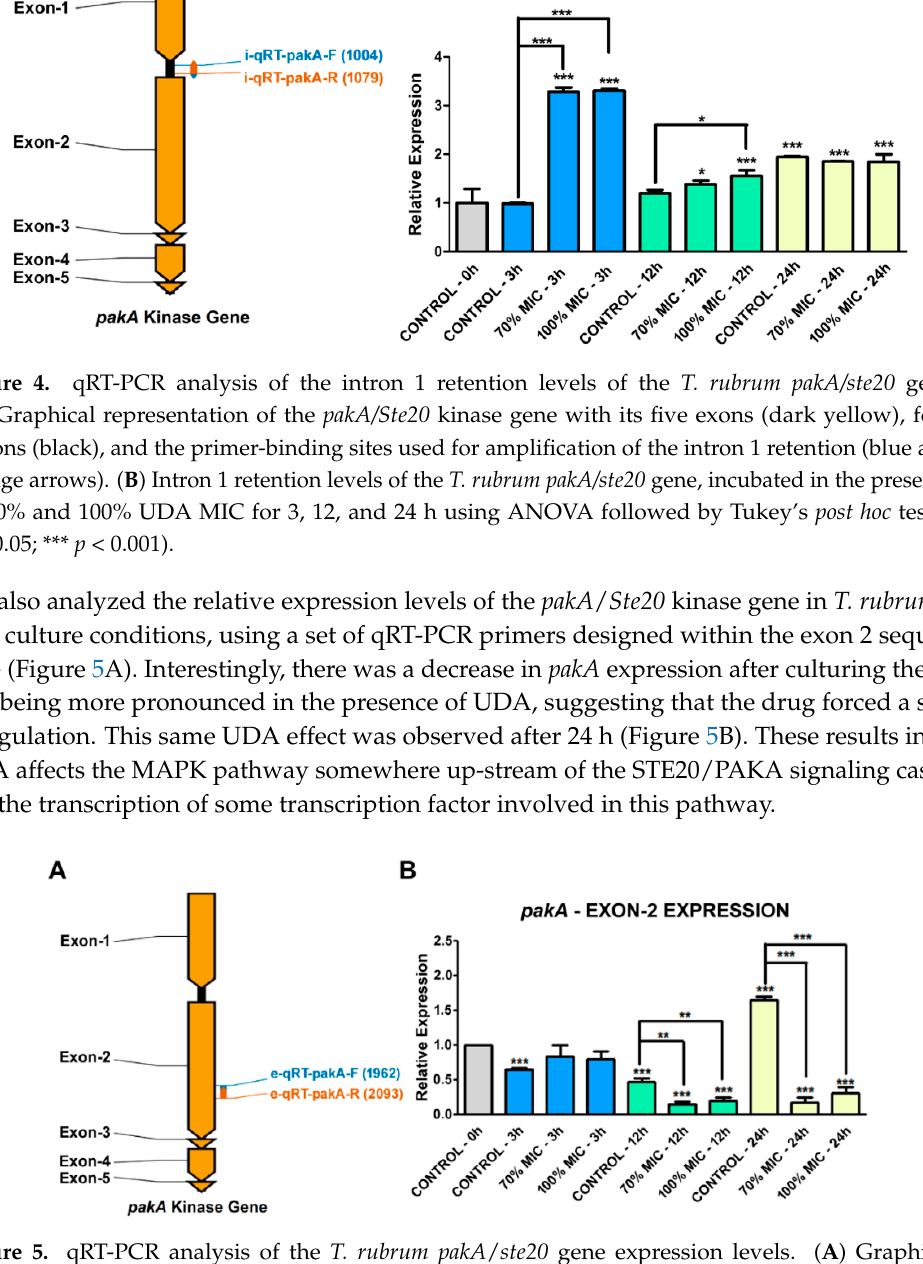
Figure 5. qRT-PCR analysis of the T. rubrum pakA / ste20 gene expression levels. ( A ) Graphical representation of the pakA / Ste20 kinase gene with its five exons (dark yellow), four introns (black), and the primer-binding sites used for gene expression analysis (blue and orange arrows). ( B ) Expression levels of the T. rubrum pakA / ste20 gene, incubated in the presence of 70% and 100% UDA MIC for 3, 12, and 24 h using ANOVA followed by Tukey’s post hoc test (** p < 0.01; *** p < 0.001).